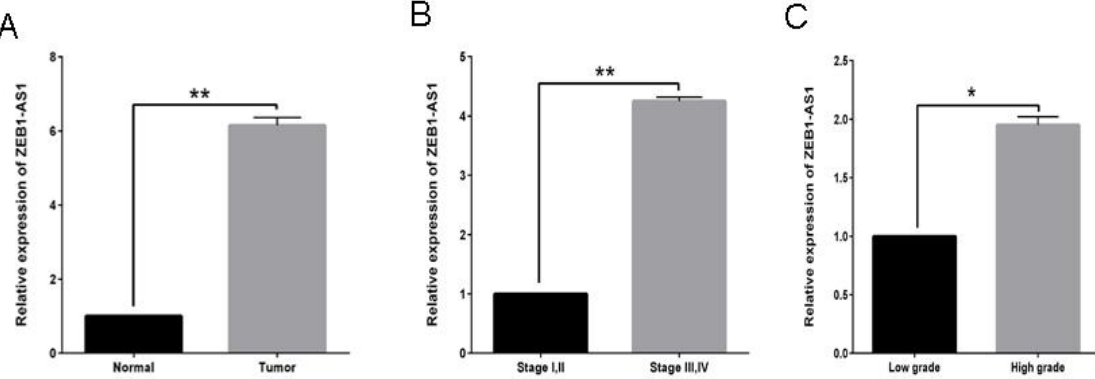
Fig. 2. The relative expression of ZEB1-AS1 in CRC tissues: (A) ZEB1-AS1 expression in tumor and adjacent normal tissues; (B) ZEB1-AS1 expression in low grade (I, II) and high grade (IIII, IV) tumor tissues; (C) Relative expression of ZEB1-AS1 in different tumor stages. Data are shown as mean±SD (*p < 0.05; **p < 0.01).